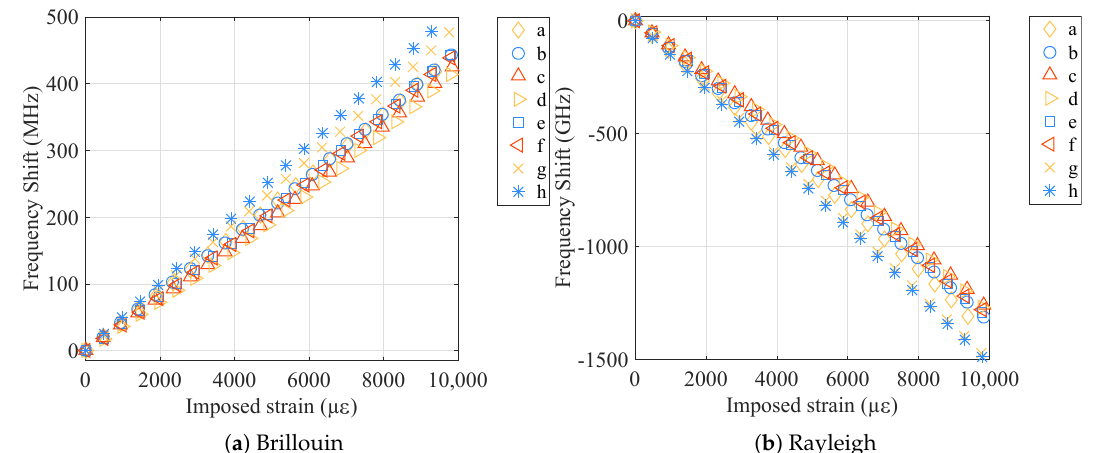
Figure 4. Frequency shift over strain curves for all the tested samples, for Brillouin and Rayleigh scatterings.